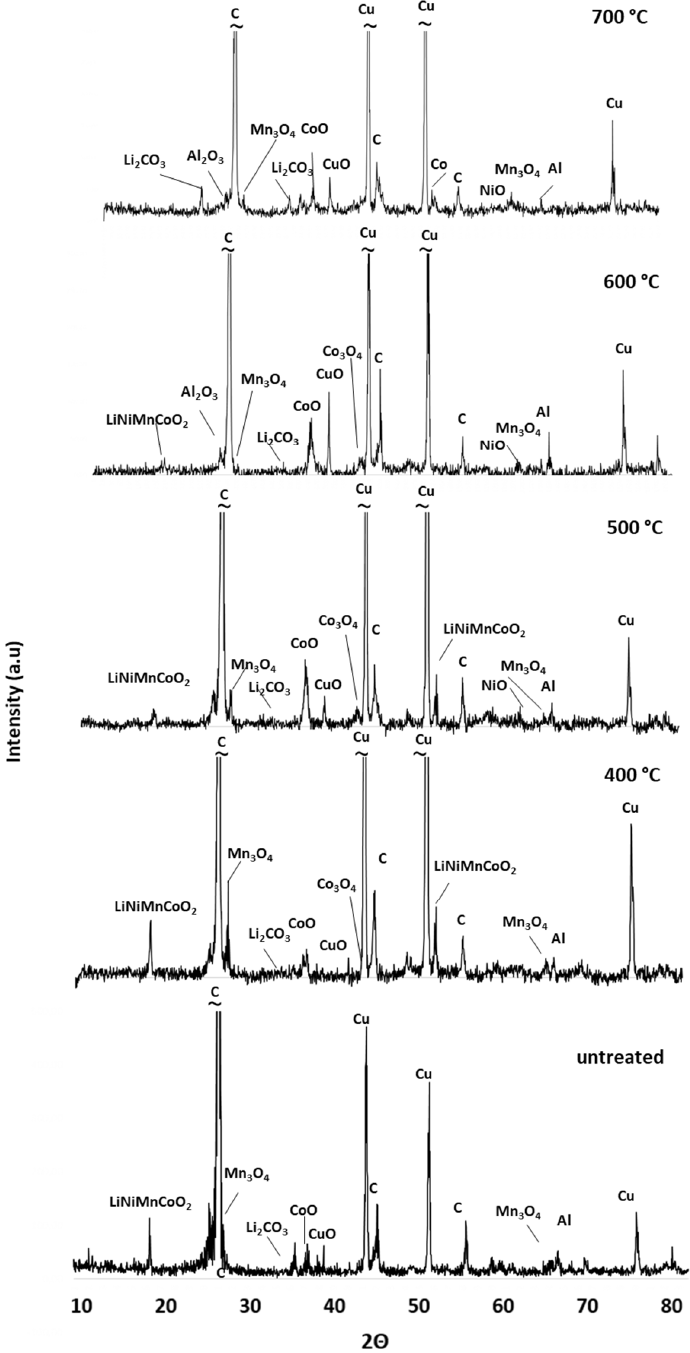
Figure 2. XRD diffractograms of samples after 60 min of pyrolysis at 400, 500, 600, and 700 °C.